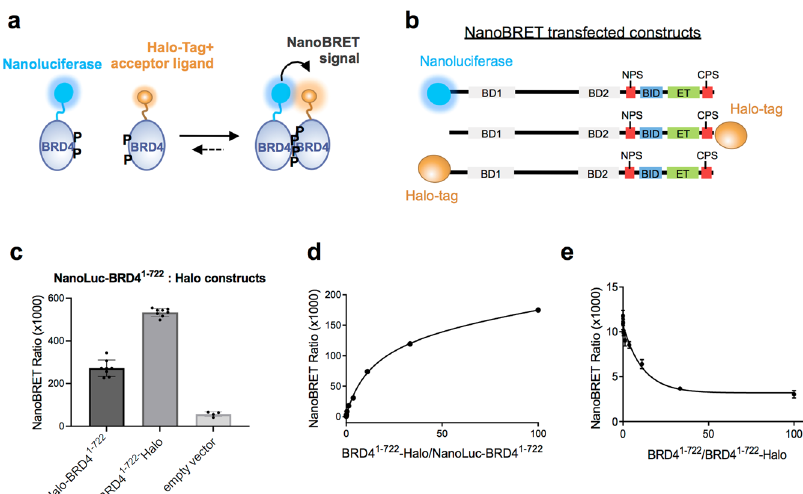
Fig. 5 NanoBRET analysis of BRD4 dimerization in cells. a Schematic summary of the NanoBRET assays to test BRD4 homo-dimerization in HCT116 cells. The curved black arrow represents Bioluminescence Resonance Energy Transfer (BRET) between the Nanoluciferase donor (blue circle) and the Halo-tag acceptor ligand (orange circle). b Overview of the NanoBRET transfected constructs used in the NanoBRET experiments, with BRD4 1 – 722 tagged at the N-terminus with Nanoluciferase, and at the N-terminus or at the C-terminus with Halo-tag. c NanoBRET signal observed using NanoLuc-BRD4 1 – 722 and Halo-BRD4 1 – 722 (dark grey bar) or NanoLuc-BRD4 1 – 722 and BRD4 1 – 722 -Halo (grey bar). The single measurements and the mean with SD are reported ( n = 8 for samples and n = 4 for control independent experiments). d Titration NanoBRET experiments where increasing amounts of acceptor DNA (BRD4 1 – 722 -Halo) were transfected with a fi xed amount of donor DNA (NanoLuc-BRD4 1 – 722 ). The mean with the standard error of the mean (SEM) is reported ( n = 4 independent experiments) e Competition NanoBRET experiments where increasing amount of untagged BRD4 1 – 722 DNA were transfected with a fi xed amount of donor and acceptor DNA pair (NanoLuc-BRD4 1 – 722 and BRD4 1 – 722 -Halo). The reduction of the NanoBRET signal at increasing values of untagged/Halo-tagged BRD4 1 – 722 ratio indicates a speci fi c competition of the untagged protein towards BRD4 1 – 722 -Halo for binding to NanoLuc- BRD4 1 – 722 . The mean with SEM is reported ( n = 4 independent